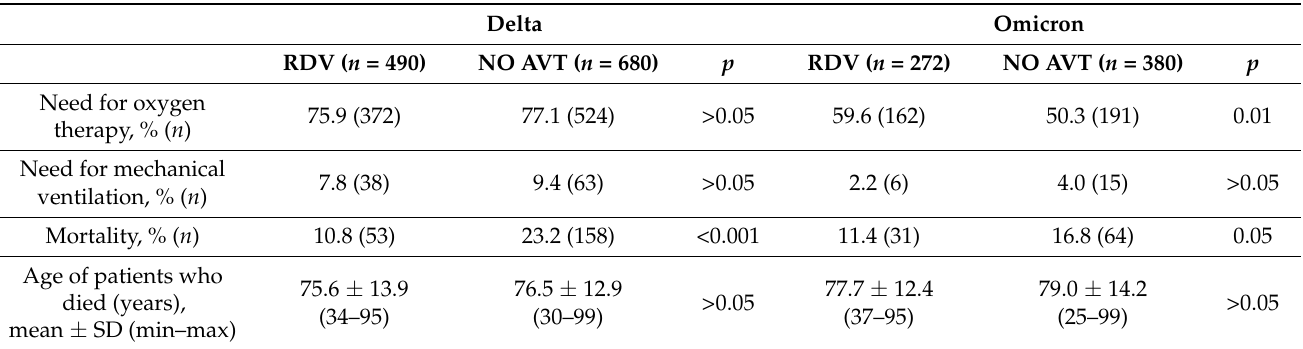
Table 4. Endpoints of hospitalized patients during Delta and Omicron waves with regard to remde- sivir (RDV) treatment.